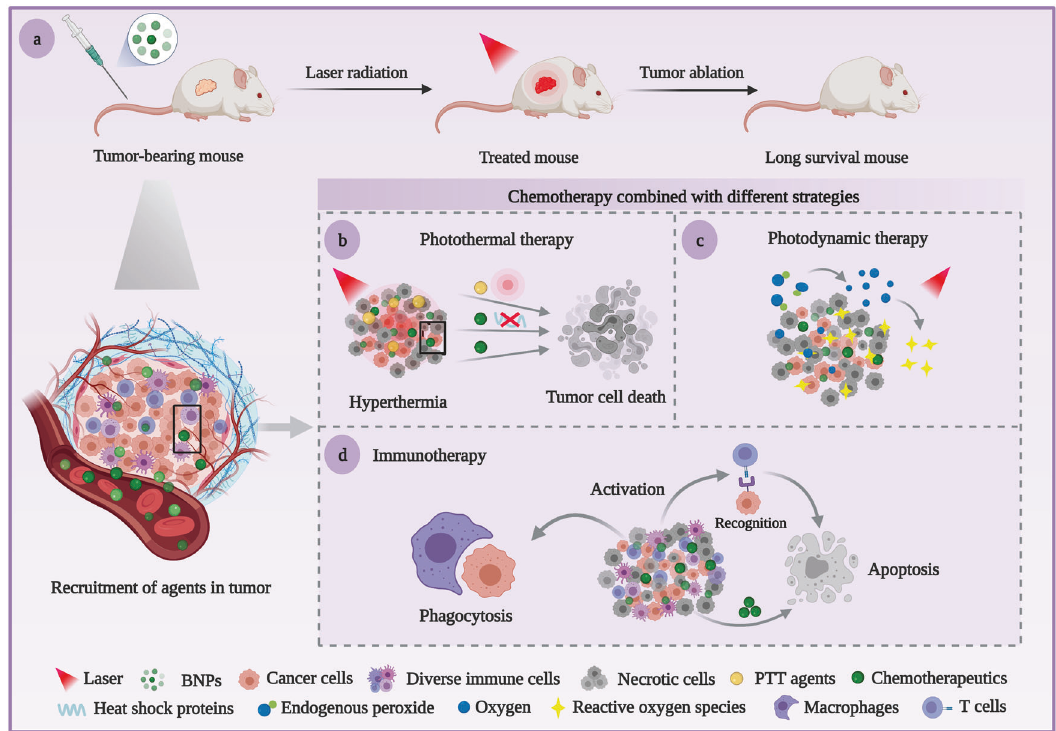
Fig. 3 Schematic illustration of chemotherapy combined with different modalities against tumors based on cell membrane vectors. a After the tumor-bearing mice being injected with BNPs targeting tumor sites, the tumor is obviously inhibited by combination therapy of chemotherapeutic with laser radiation or immune response. b PTT agents elevate the temperature around tumor sites by photothermal conversion, and chemotherapeutic agents synergistically down-regulated the expression of heat shock proteins, reduce the heat resistance, and directly induce apoptosis of tumor cells. c Aside from tumor toxicity of chemotherapeutic agents, endogenous peroxide is effectively converted into oxygen to alleviate tumor hypoxia and oxygen alters to tumor-toxic reactive oxygen species under laser radiation